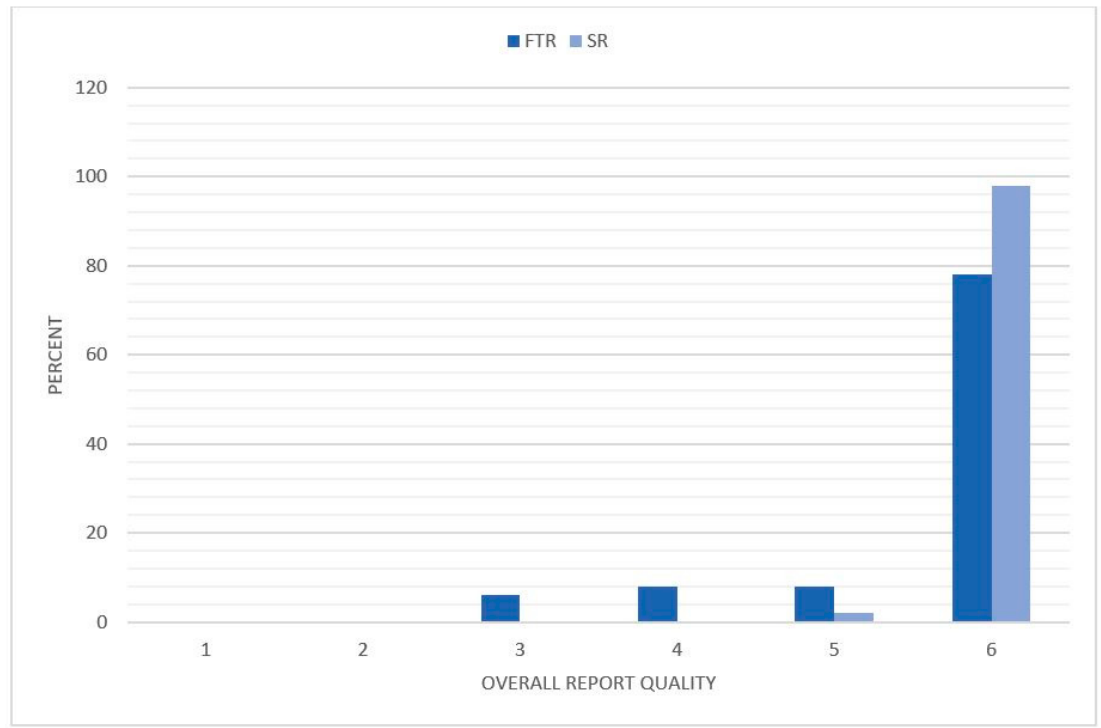
Figure 7. Distribution of the overall report quality. The reviewers rated the reports based on a Likert scale with a range from 1 to 6 (1 = insufficient, 6 = excellent). The degree of the overall report quality is illustrated on the x -axis and the percentage distribution on the y -axis. FTR = free text reports; SR = structured reports.